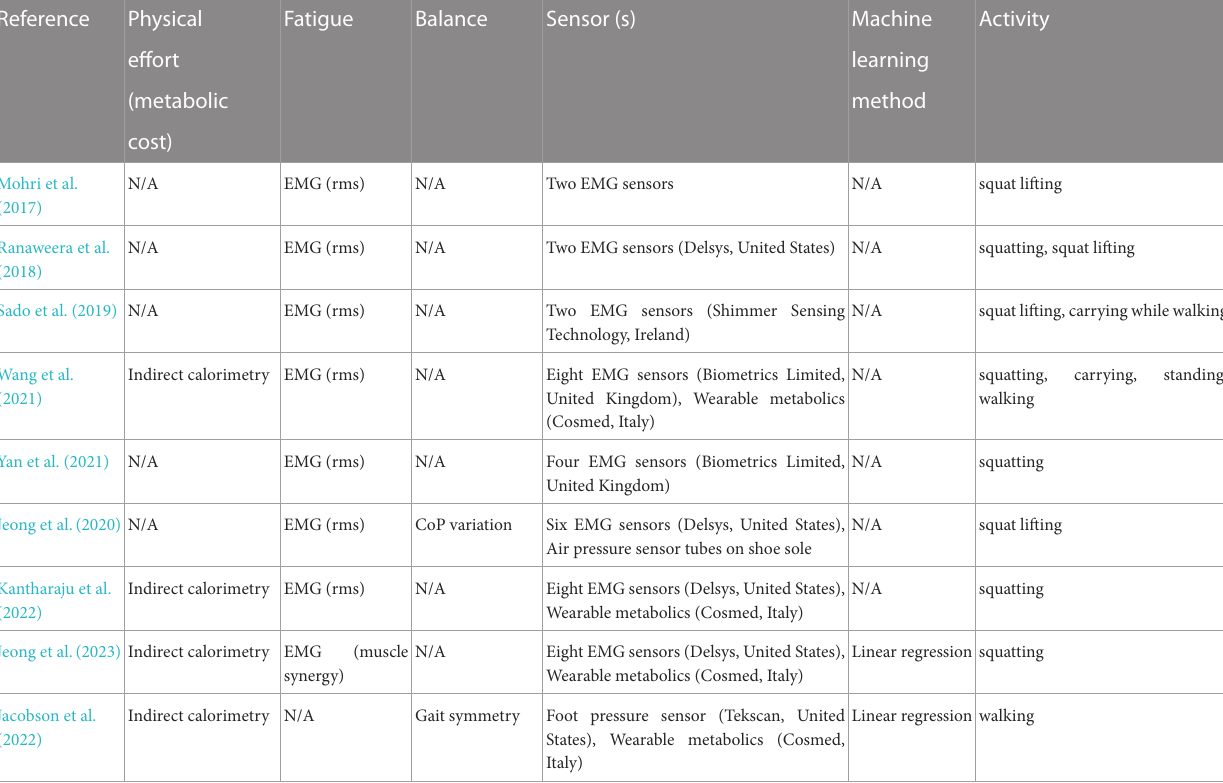
TABLE1 Pastresearchonexoskeletonsdesignedtoassistsquattingmovements.Acomparisonofmethodsusedtomeasuremetaboliccost,fatigueandbalance, thetypeofsensorsused,useofmachinelearningmethodsandtheactivitiesstudied.